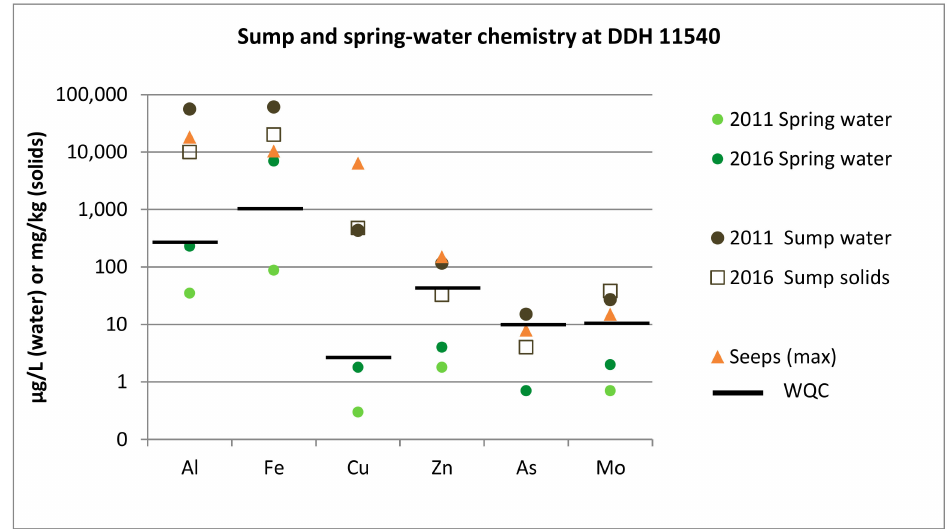
Figure 9. Wetland spring at drill waste sump. Drill waste sump contents were sampled in 2011 (water) and 2016 (solids), as was a wetland spring downgradient. Concentrations for water are in µ g / L and for solids are in mg / kg, both on the left vertical axis. Black bars—WQC for aquatic life [23]. For hardness-dependent metals a hardness of 25 mg / L was applied. Seep data was collected by PLP